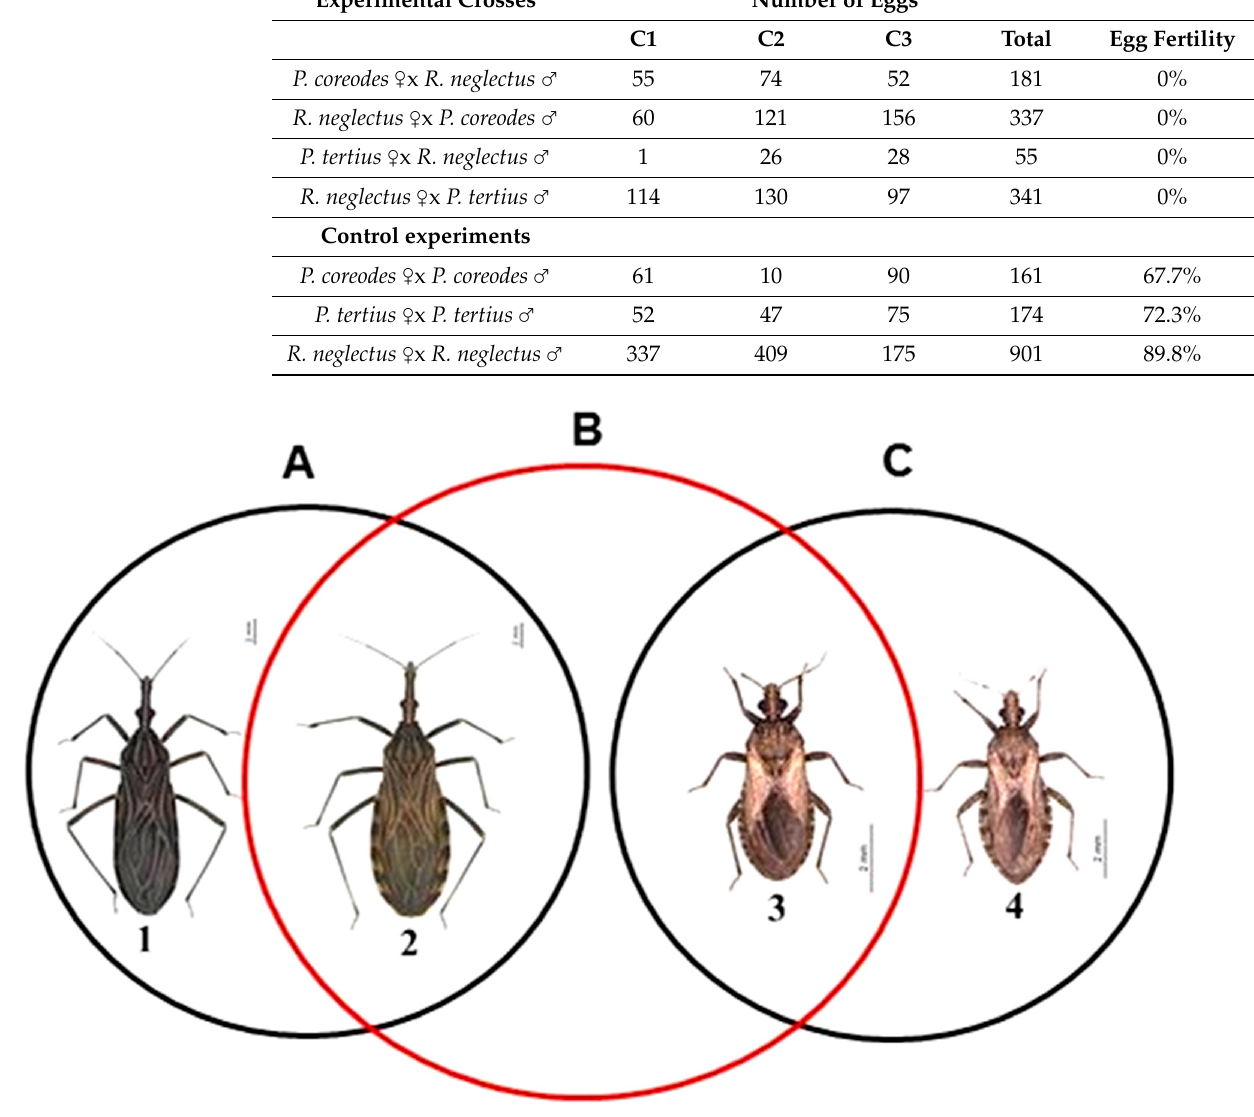
Figure 1. Scheme representing the intrageneric ( A , C ) and intergeneric ( B ) crosses of the Rhodniini tribe. Note that the black circles represent reproductive compatibility and hybrid formation between Rhodnius spp. ( A ) and between Psammolestes spp. ( C ) and the red circle demonstrates reproductive incompatibility and absence of hybrid formation between the Rhodnius and Psammolestes genera ( B ). 1: R. prolixus , 2: R. neglectus , 3: P. tertius and 4: P. coreodes . Bar: 2 mm.